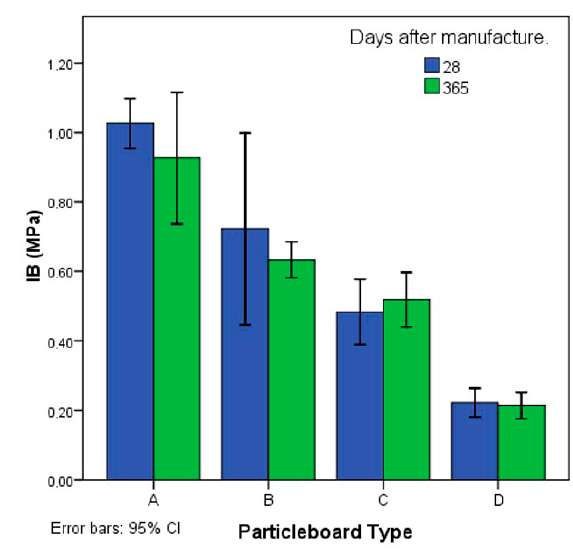
Figure 6. Average values of internal bond or tensile strength (IB) after 28 and 365 days of curing based on the type of particleboard. CI, confidence interval.